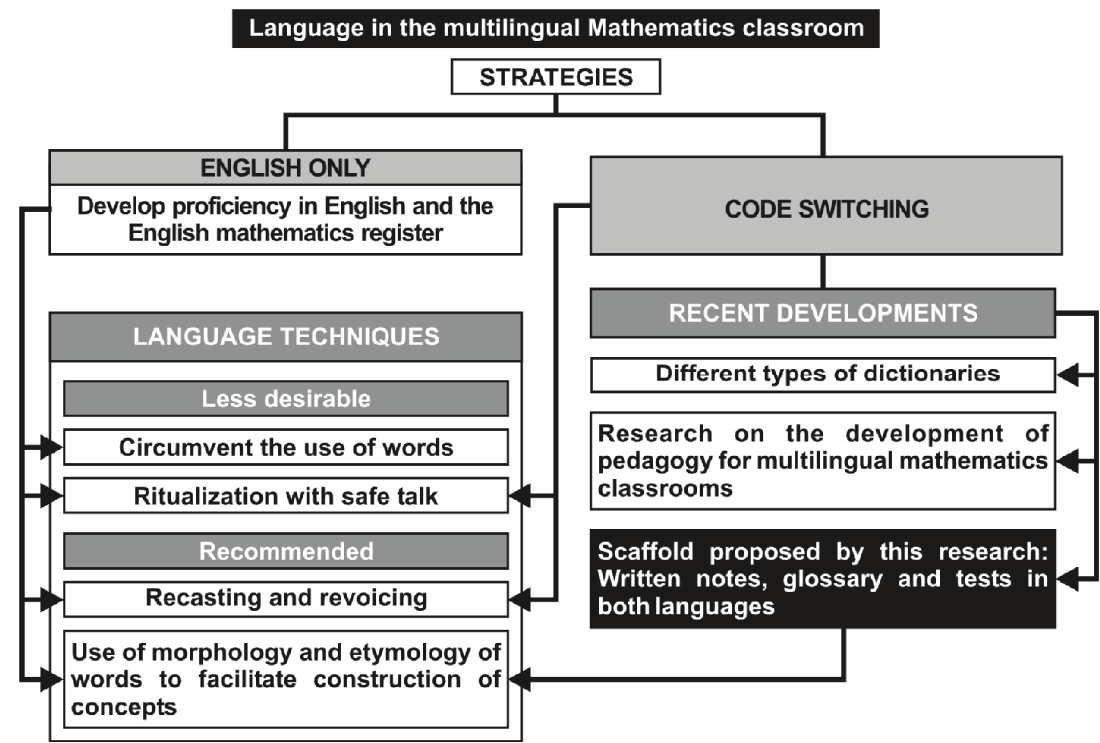
Figure 1: Strategies, techniques and recent